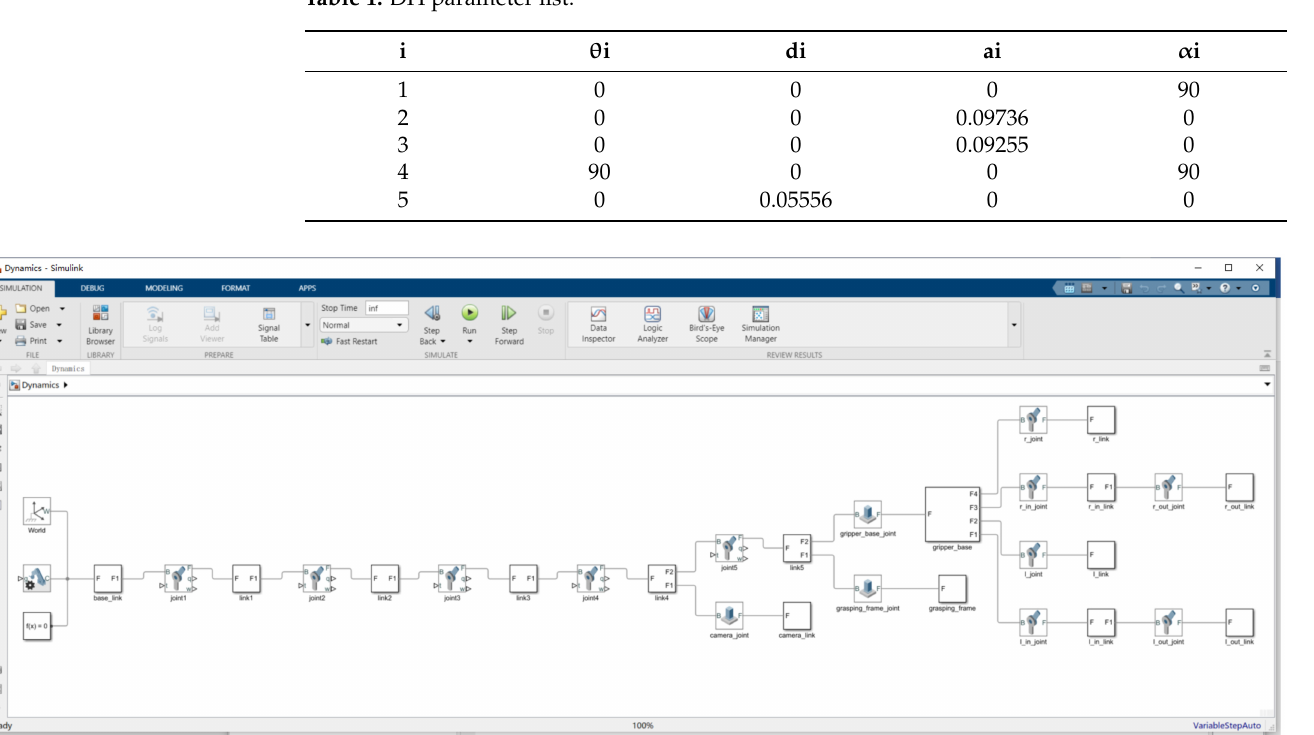
Figure 6. Dynamic model in Simscape.